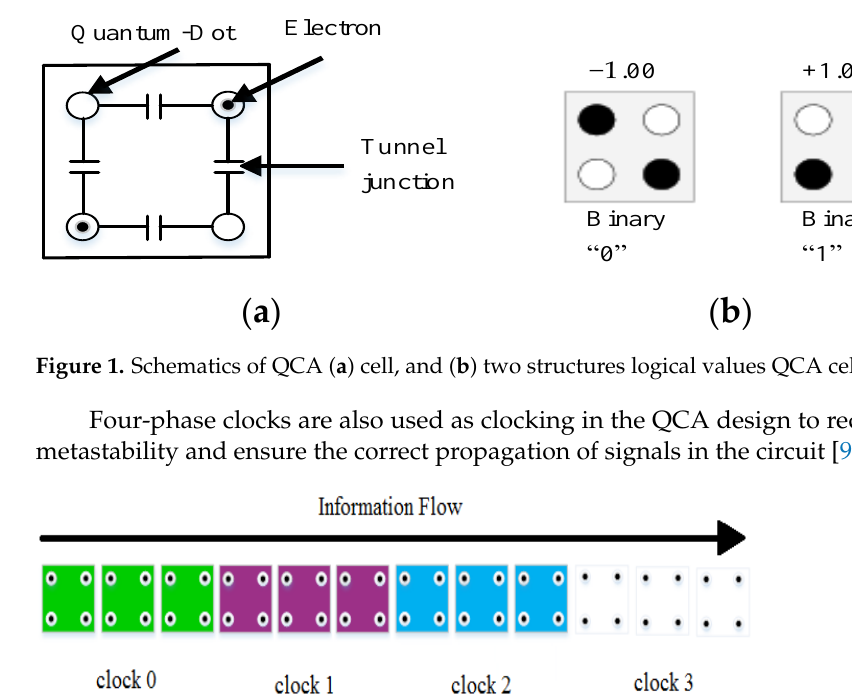
Figure 2. Clock zones for QCA wire.